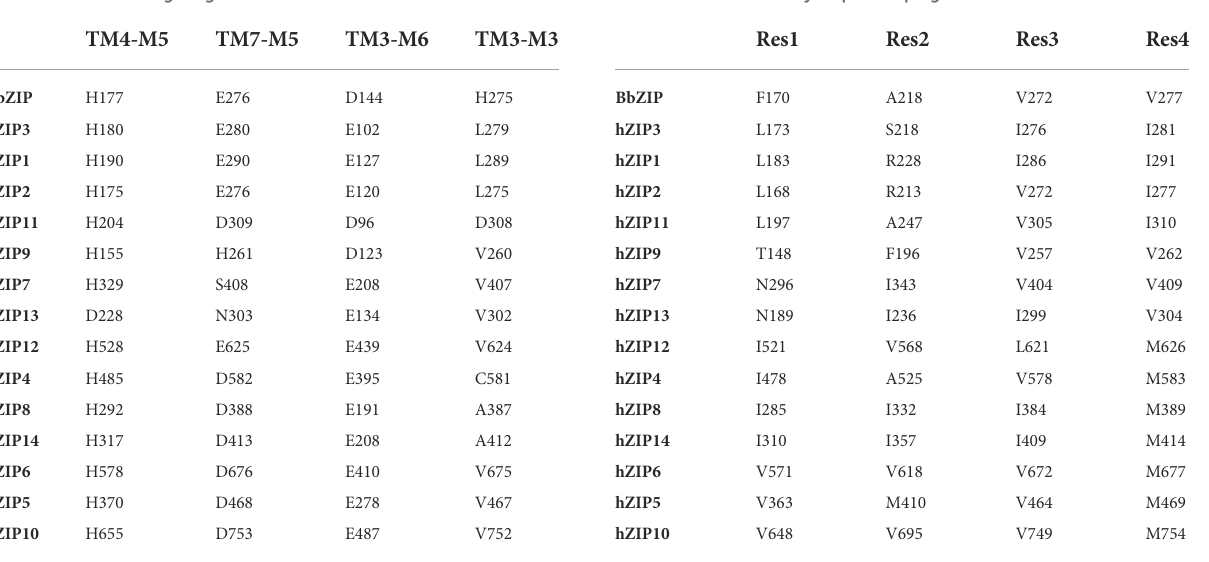
TABLE 8 Intracellular gating residues. TABLE 9 Intracellular hydrophobic